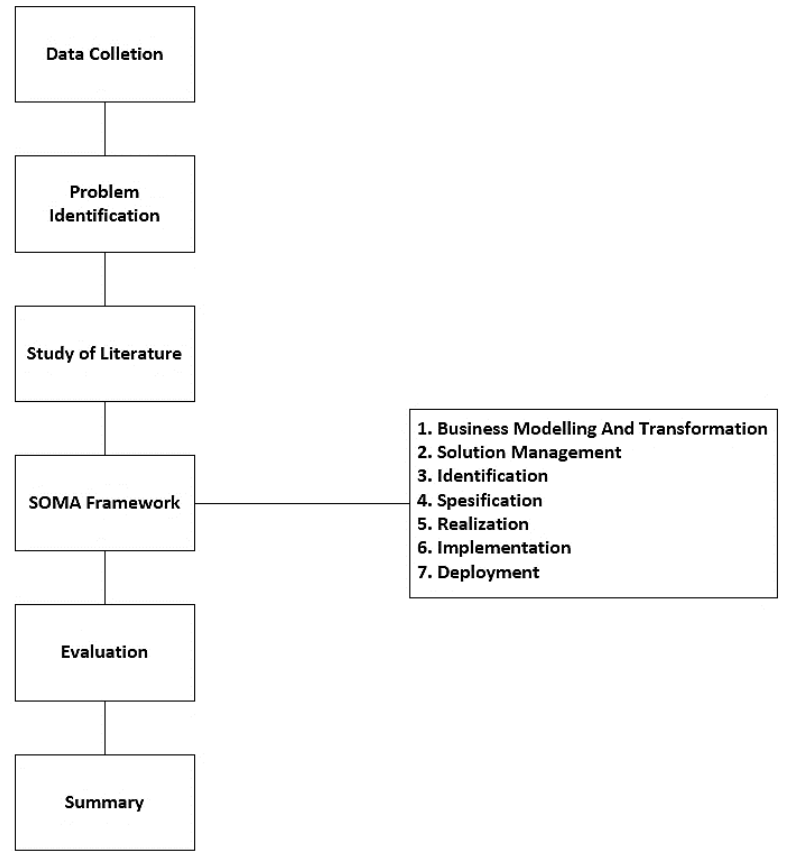
Figure 3. Research